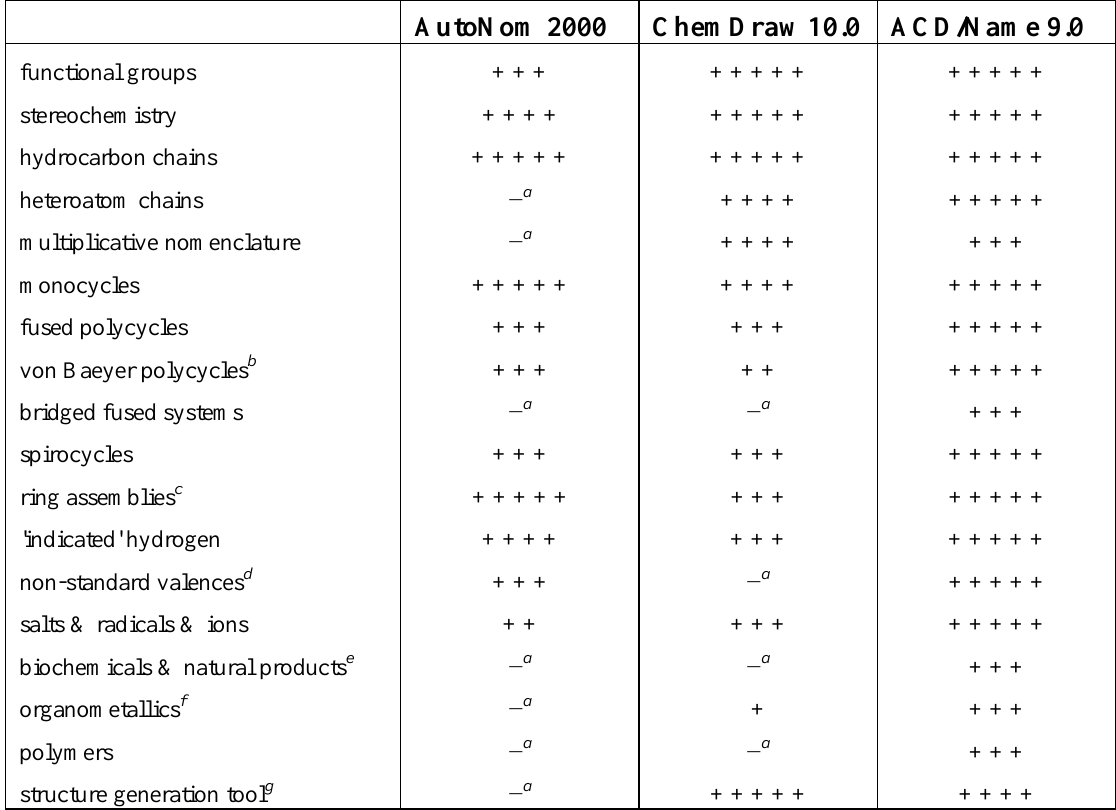
Table 2 . Comparison of functional classes actually supported by the used nomenclature